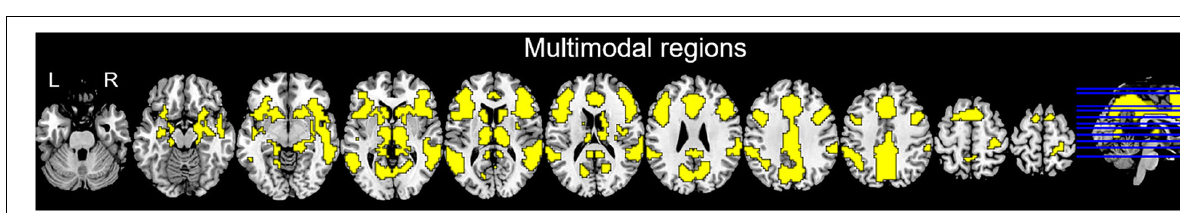
FIGURE 3 | Binary multimodal regions defined by conjunction